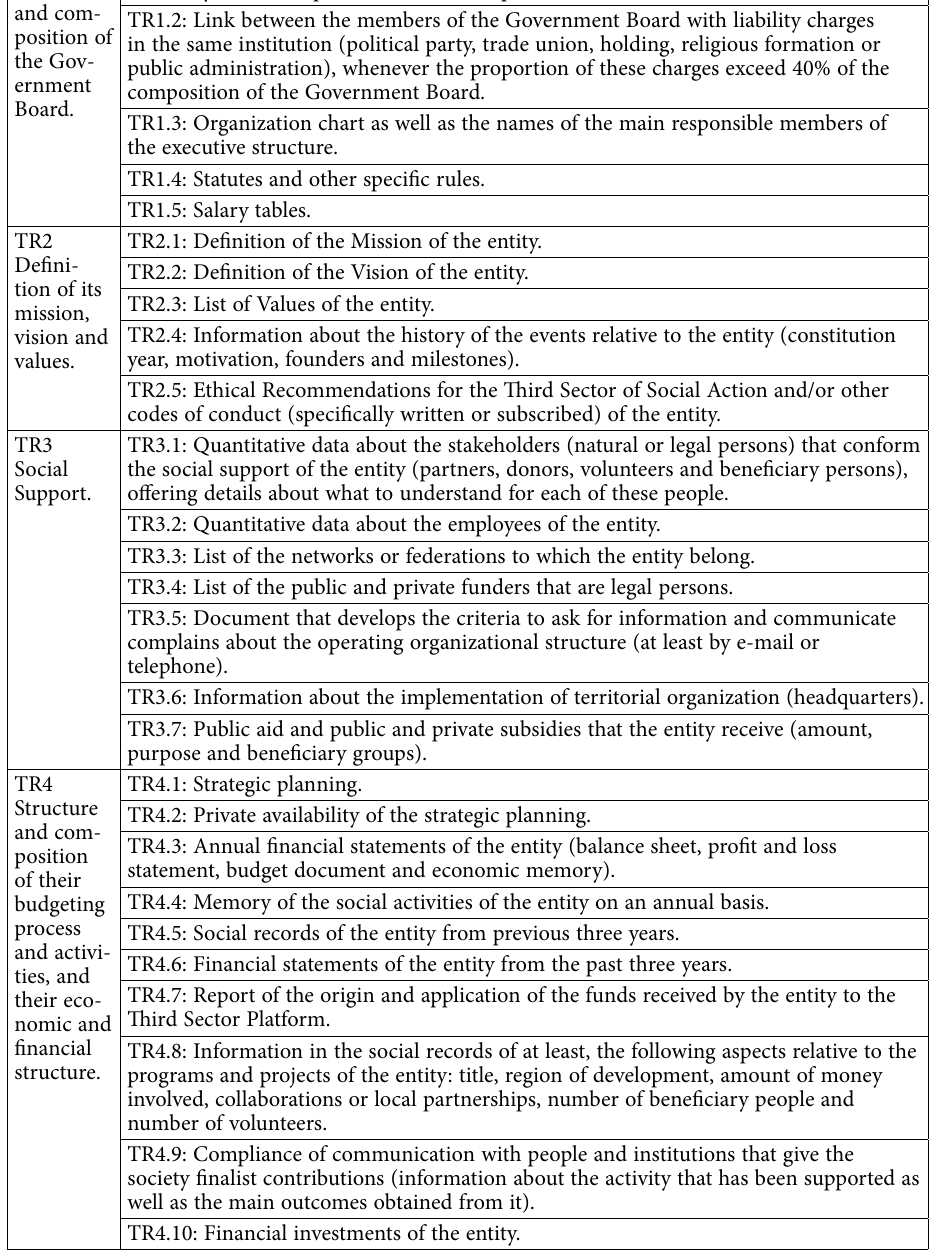
Table 1. Variable definitions Blocks of indicators